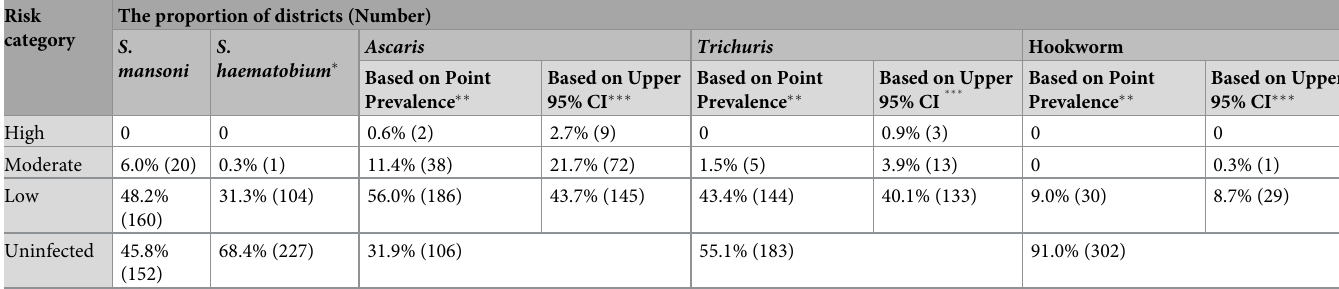
Table 4. The distribution of districts according to risk category for schistosomiasis and soil-transmitted helminth, Yemen,